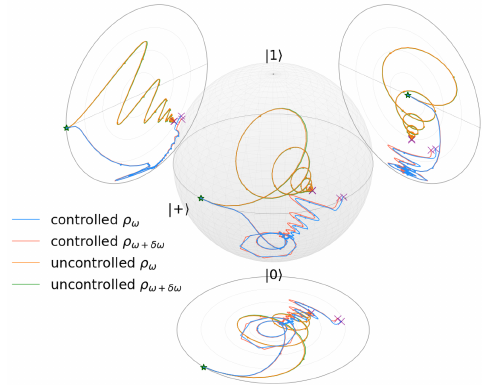
Figure 5: Controlled and uncontrolled dynamics of the states ρ ω and ρ ω + δω dis- played on the single-qubit Bloch sphere. The control fields applied are shown in Fig. 6(b). The green star and pink cross indicate the start and end of the evolution respectively. The density of dots reflects the speed of the evolution, with a low den- sity indicating high